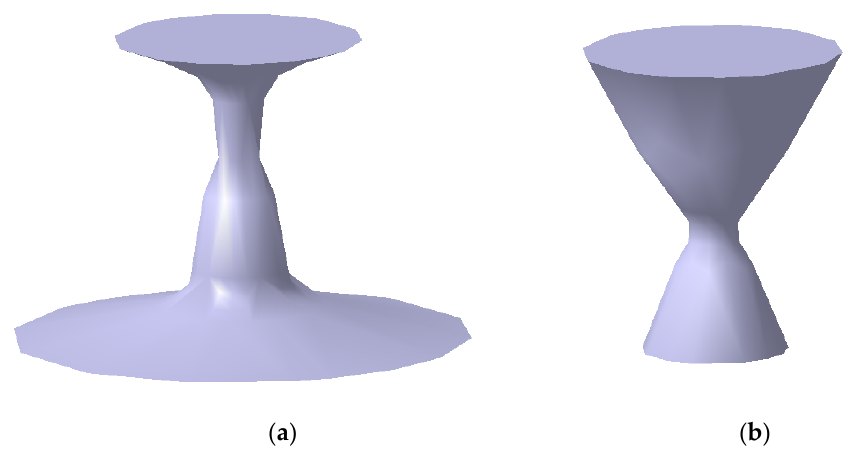
Figure 10. The shape of a heat source per welding speed. ( a ) 1.5 m/min; ( b ) 2.0 m/min. In addition, the results of heat transfer analysis using three different heat sources are shown in Figures 11 and 12 and it was found that they are similar to the fusion zone line of cross-sectional observation results in Figure 10.